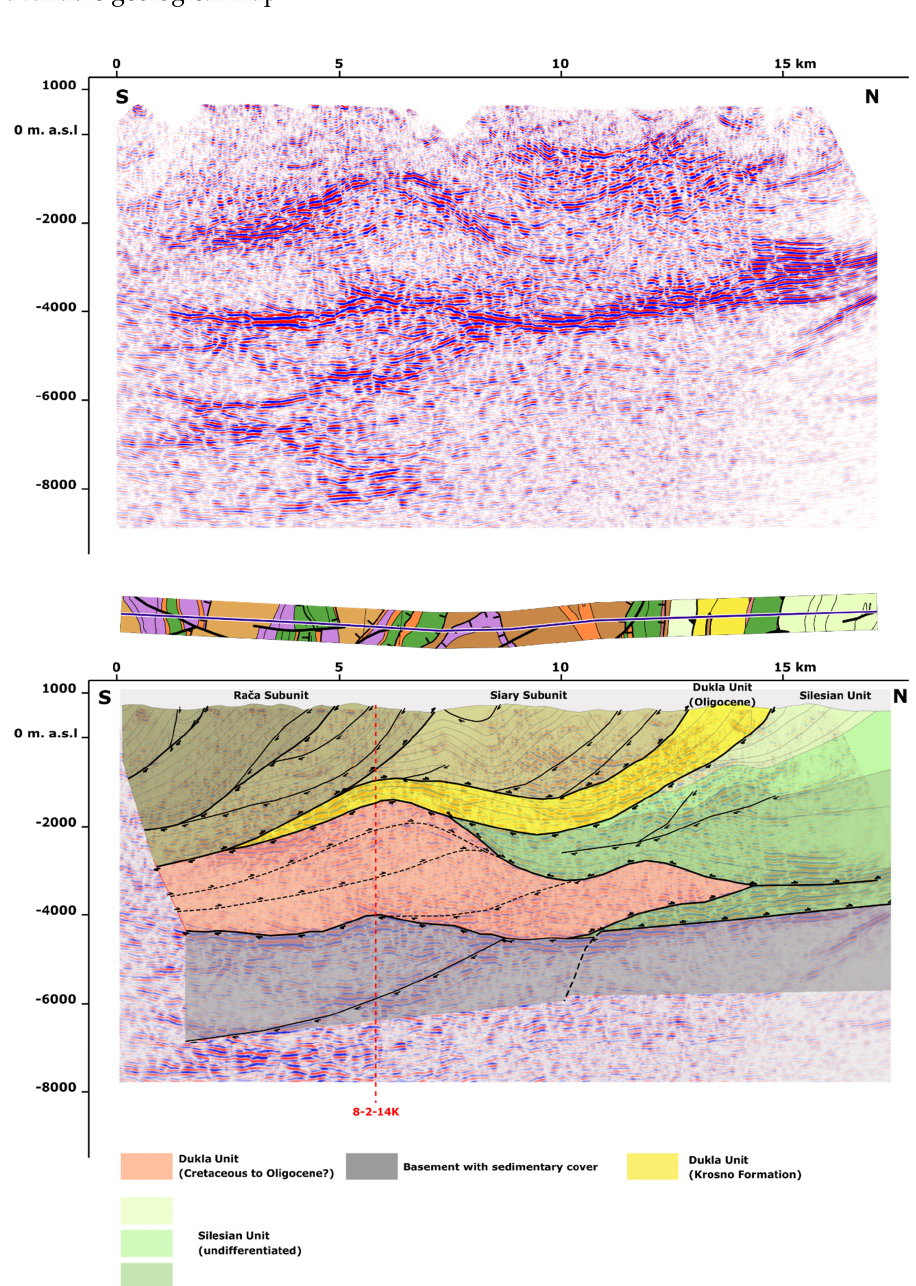
Figure 13. Depth migrated seismic profile 12-2-14K (upper panel) and its interpretation (lower panel). The black vertical line indicates an intersection with the 8-2-14K seismic profile. Black lines—thrust faults, dashed black lines—inferred normal faults. Red dashed line—intersection with seismic profile 8-2-14K. Above the interpreted seismic profile a fragment of the geological map is presented. Abbreviation: m. a.s.l—meters above sea level.